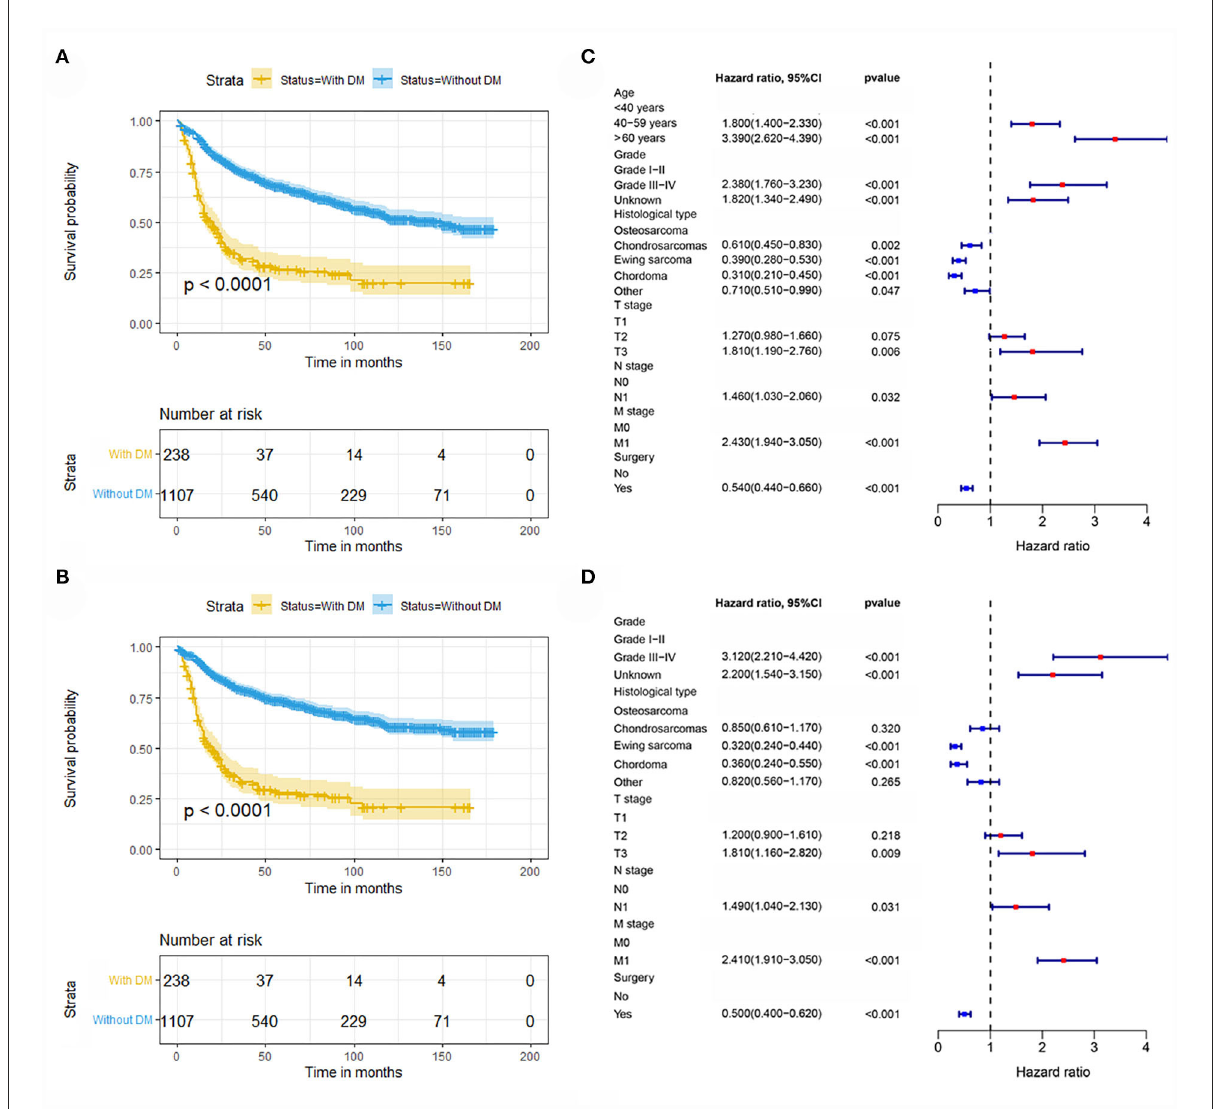
FIGURE2 Kaplan–Meier survival analysis to investigate the impact of DM on OS (A) and CSS (B) in patients with POSNs. The forest plot showed the results of multivariate Cox regression analysis, where DM was significantly associated with OS (C) and CSS (D) of patients with POSNs.